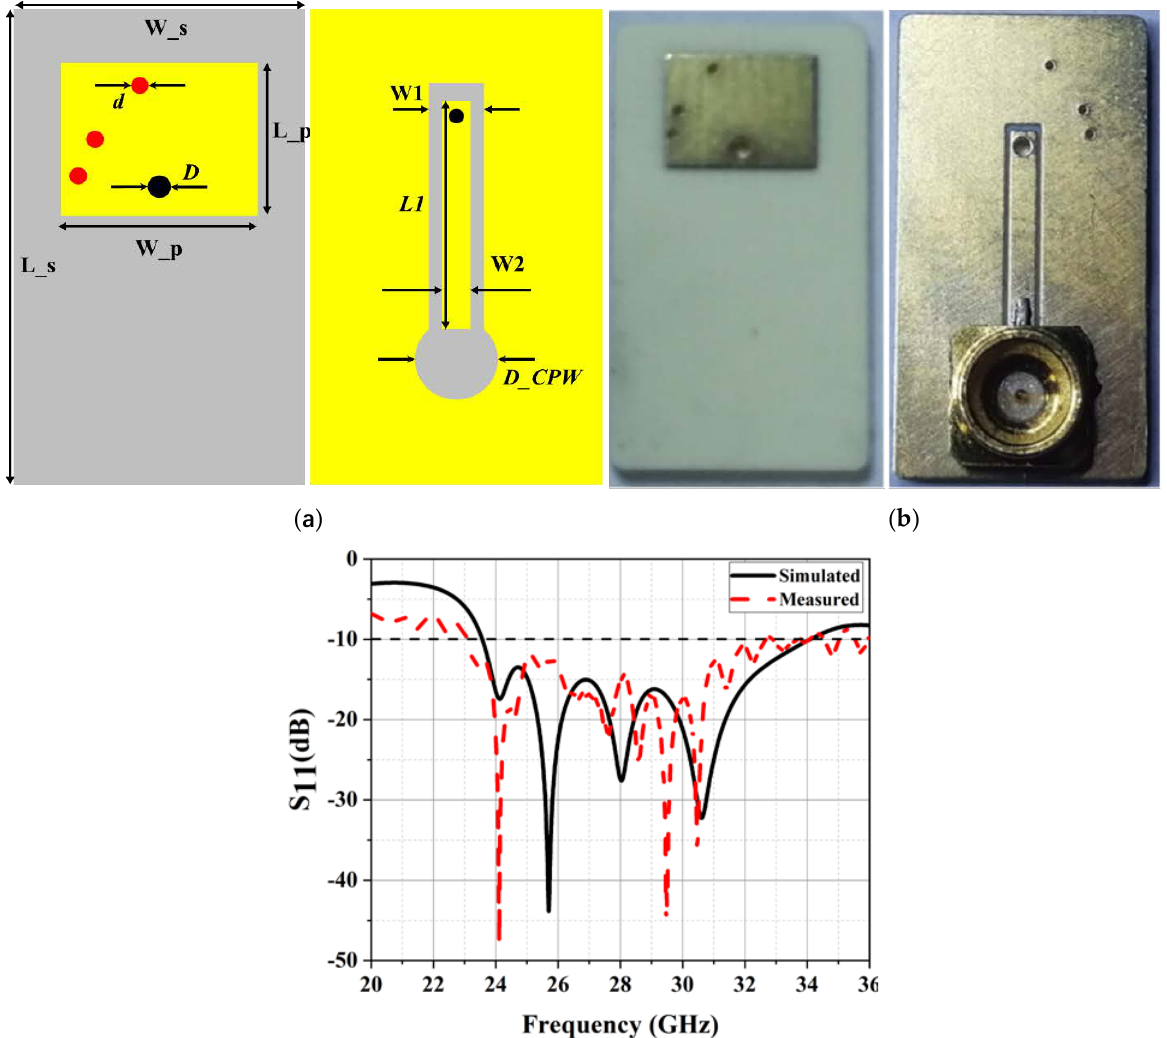
Figure 5. ( a , b ) Top and bottom view of simulation and measurement models and ( c ) the compari- son of simulated and measured S 11 parameters. Relative parameter values are (mm): W_s = 5.7, L_s = 13.7, W_p = 3.3, L_p = 4.3, W 1 = 0.8, W 2 = 0.6, D = 0.5, d = 0.2, L 1 = 6.02, D_CPW = 2.59.